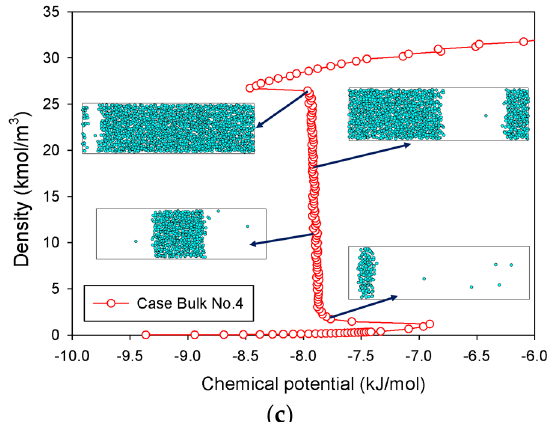
Figure 2. Bulk phase isotherms of bulk nitrogen and their molecular configurations for scenarios of ( a ) Bulk No.2, ( b ) Bulk No.3, and ( c ) Bulk No.4.